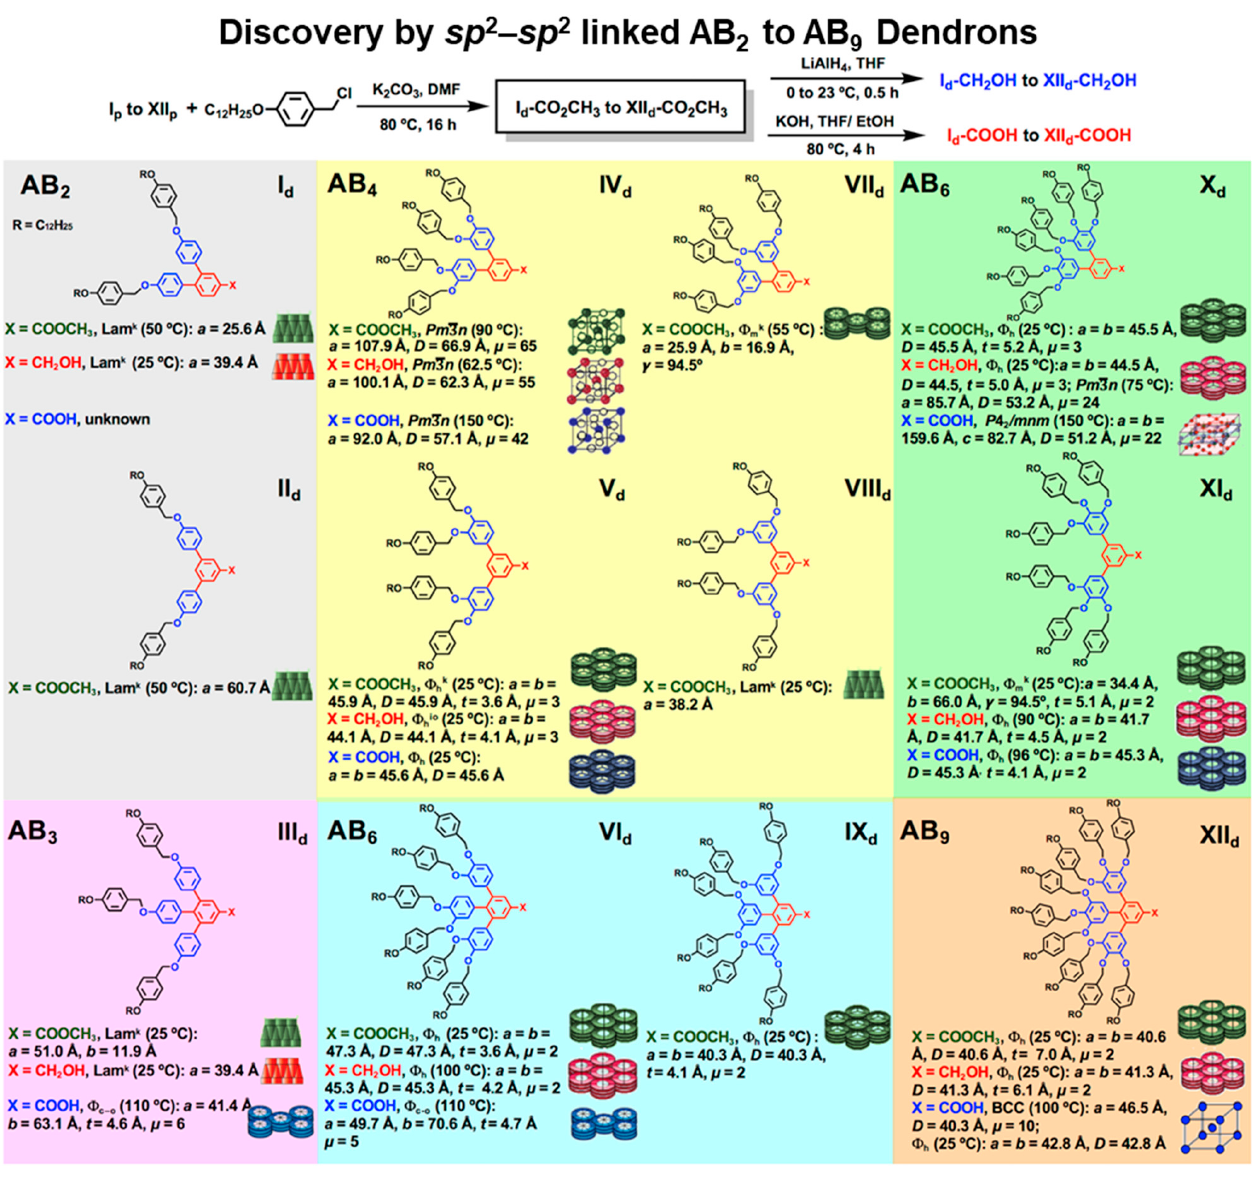
Figure 5. Structural and retrostructural analysis of supramolecular dendrimers self-assembled from a library of symmetric constitutional isomeric AB 2 to AB 9 self-assembling sp 2 - sp 2 dendrons [86]. Reproduced with permission from [86]. Copyright © 2021, American Chemical